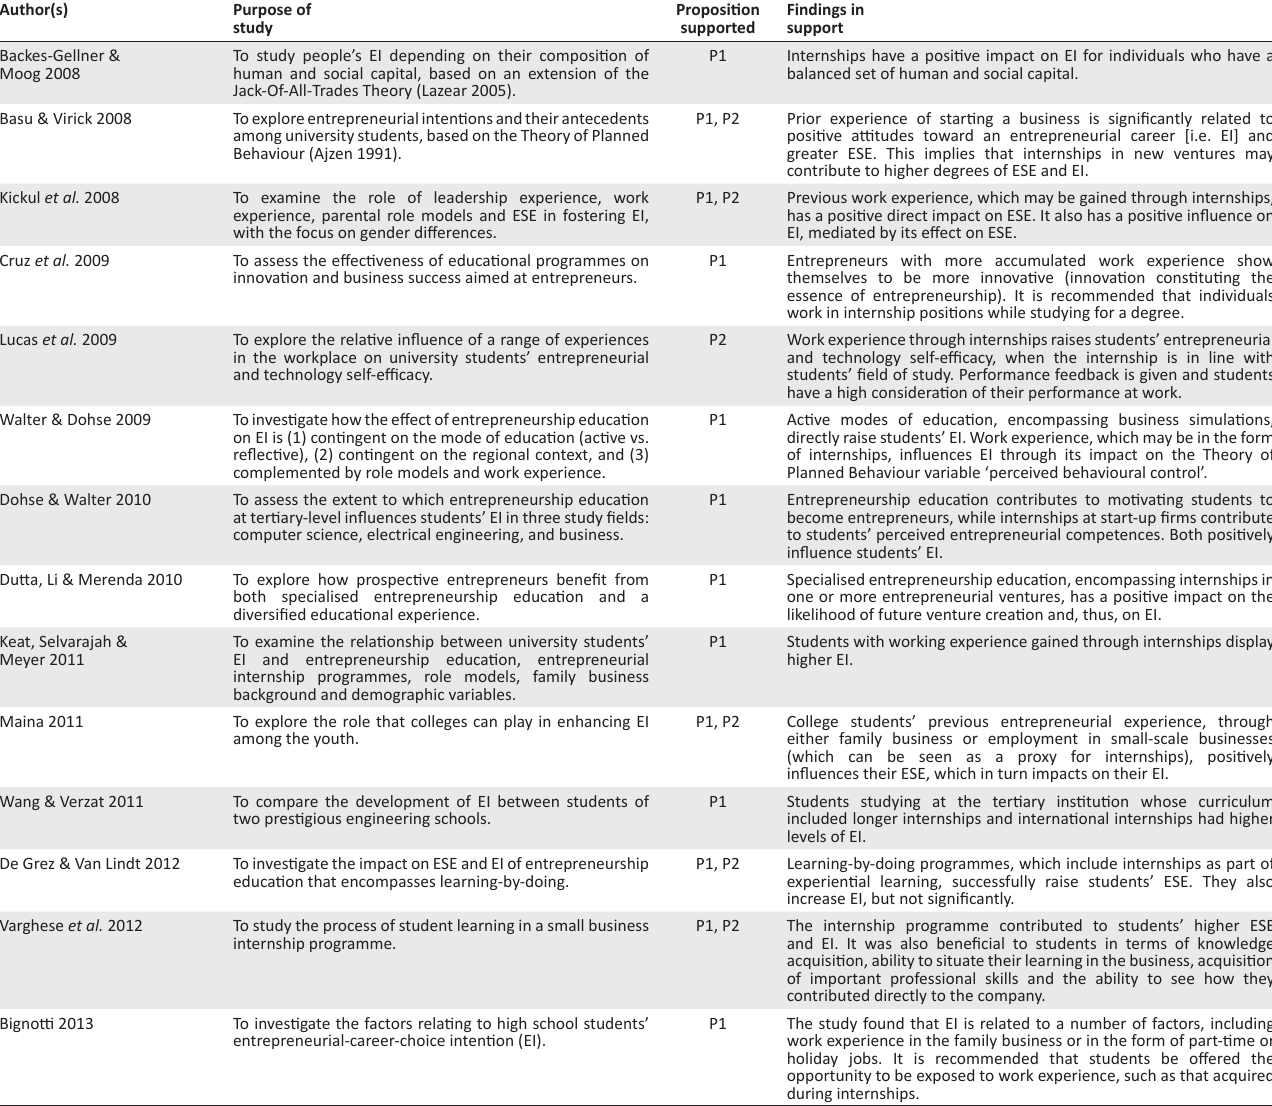
TABLE 1: Literature-based empirical support for